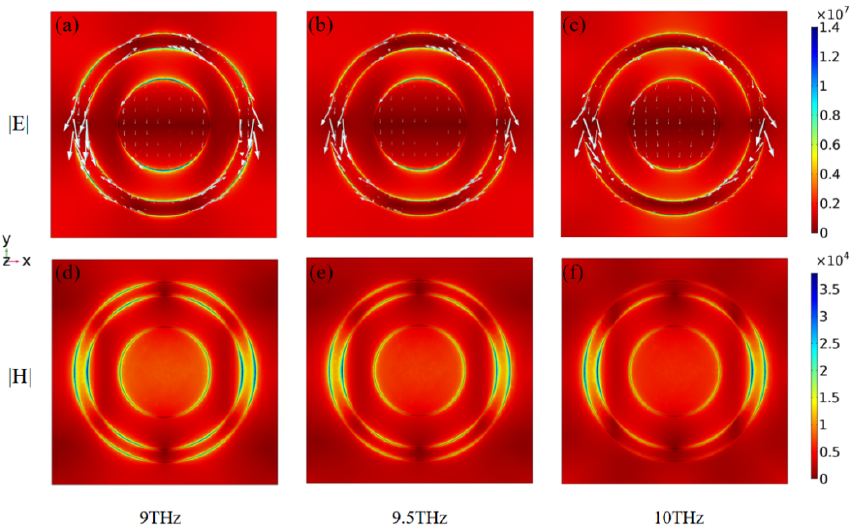
Figure 4. Current density distribution simulation diagram of electromagnetic field of absorber at different frequencies. ( a ) TE mode, f = 9 THz, ( b ) TE mode, f = 9.5 THz, ( c ) TE mode, f = 10 THz, ( d ) TM mode, f = 9 THz, ( e ) TM mode, f = 9.5 THz, ( f ) TM mode, f = 10 THz (The size and direction of the white arrows indicate the direction of current density respectively).